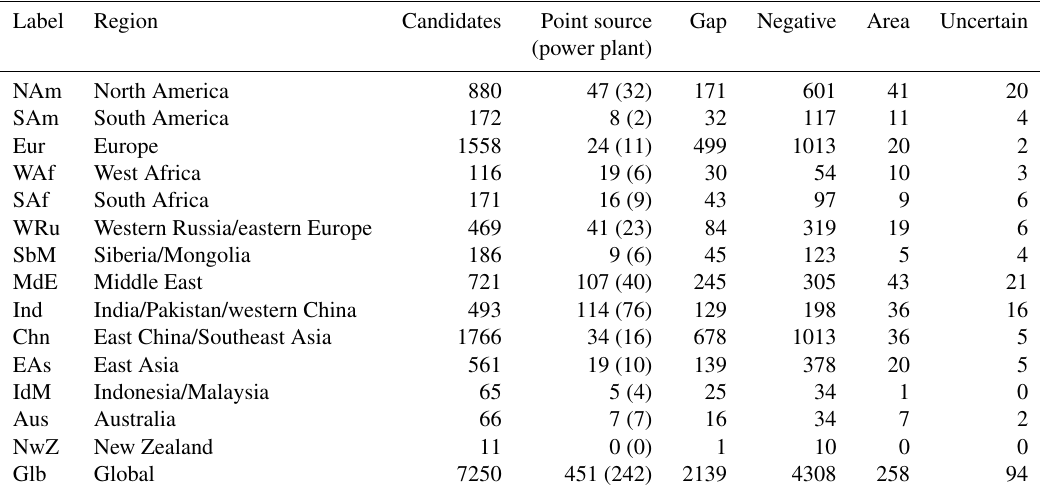
Table 3. Number of candidates and their respective classification found for the regions defined in Table 2. The number of point sources in brackets refers to the point sources associated with power plants.